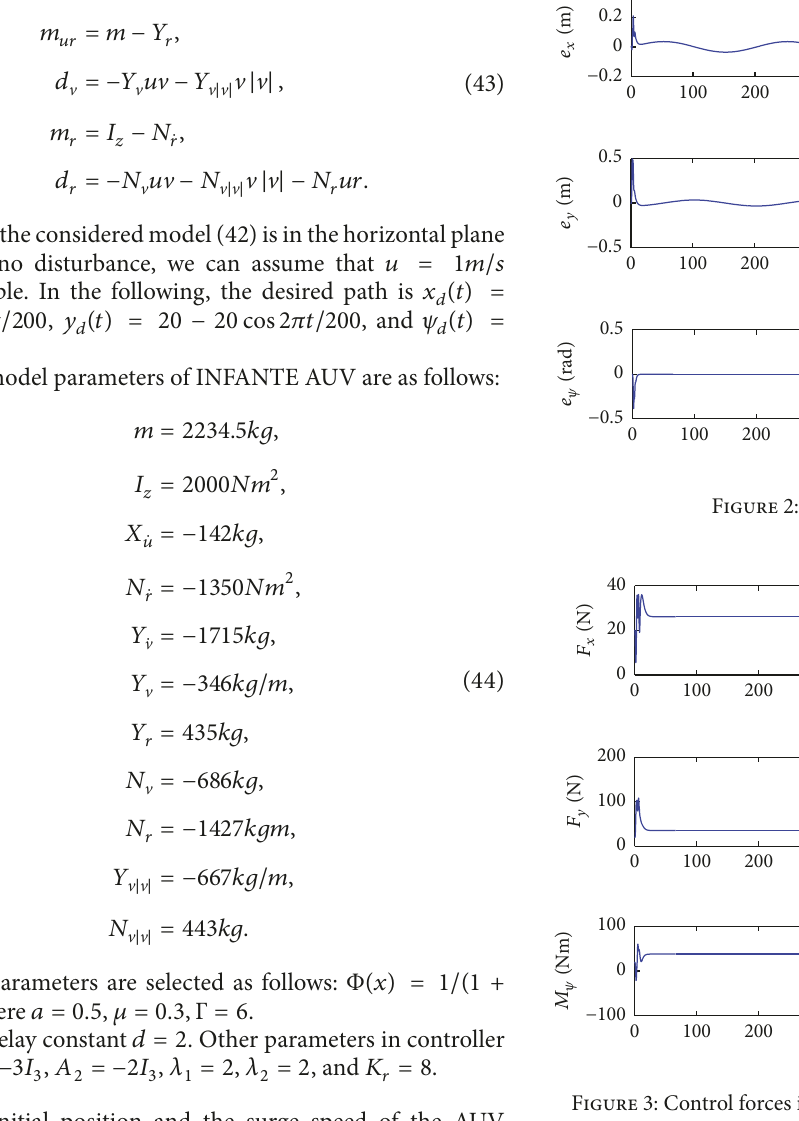
Figure 3: Control forces in 𝑥 and 𝑦 and control torque of